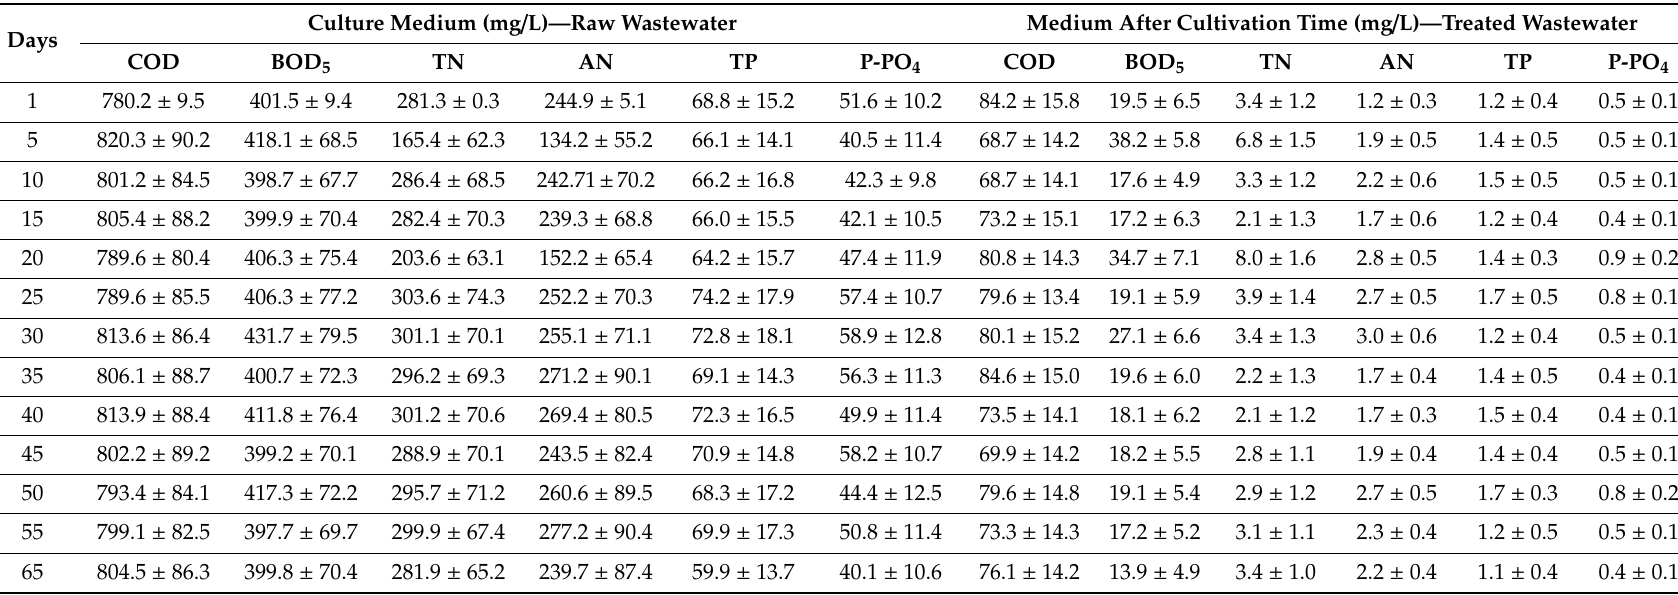
Table 3. Characteristics of the culture medium (raw wastewater) and the medium after the cultivation time (treated wastewater) in Stage 2. Culture Medium (mg / L)—Raw Days